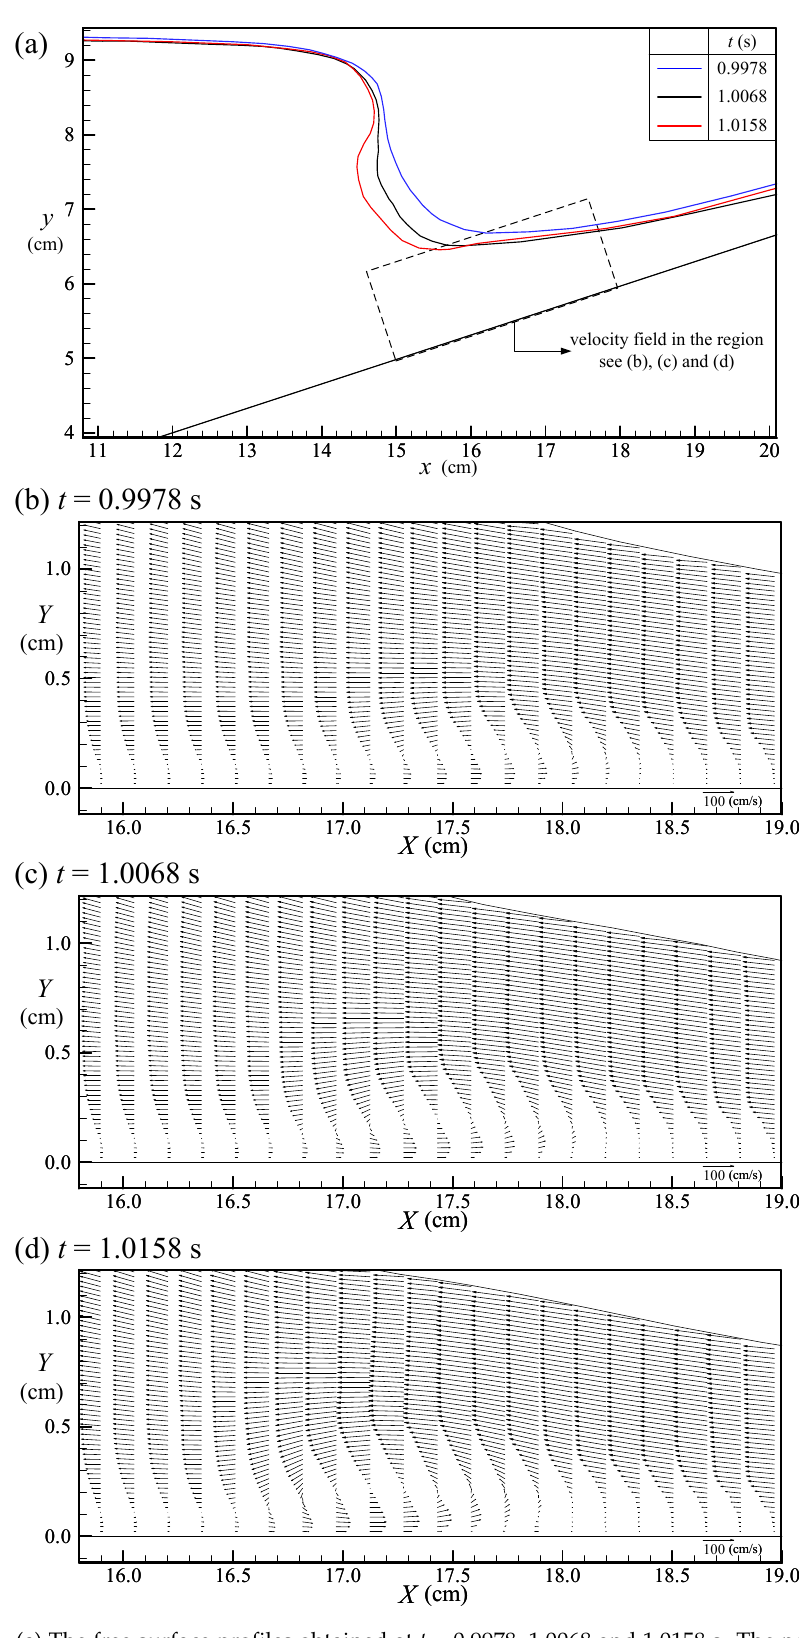
Figure 13. ( a ) The free surface profiles obtained at t = 0.9978, 1.0068 and 1.0158 s. The near-bottom velocity fields at t = ( b ) 0.9978 s; ( c ) 1.0068 s; and ( d ) 1.0158 s.